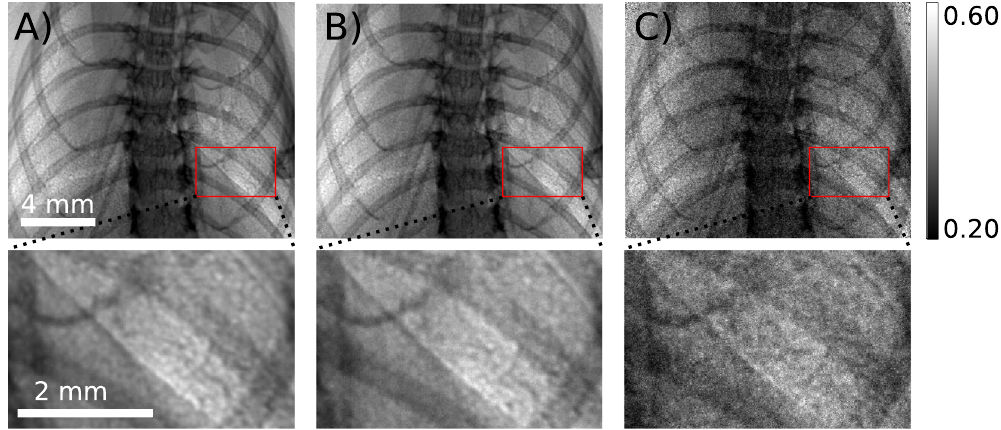
Figure 6. Ex vivo murine lungs captured with ( A ) 10 s (flat-field 150000 ADUs, dark-current 2000 ADUs), ( B ) 1 s (flat-field 15000 ADUs, dark-current 200 ADUs) and ( C ) 0.05 s exposure times (flat-field 900 ADUs, dark- current 100 ADUs) (sample-detector distance = 1.5 m, detector pixel size = 13 μ m). The red boxes highlight the magnified areas in the second